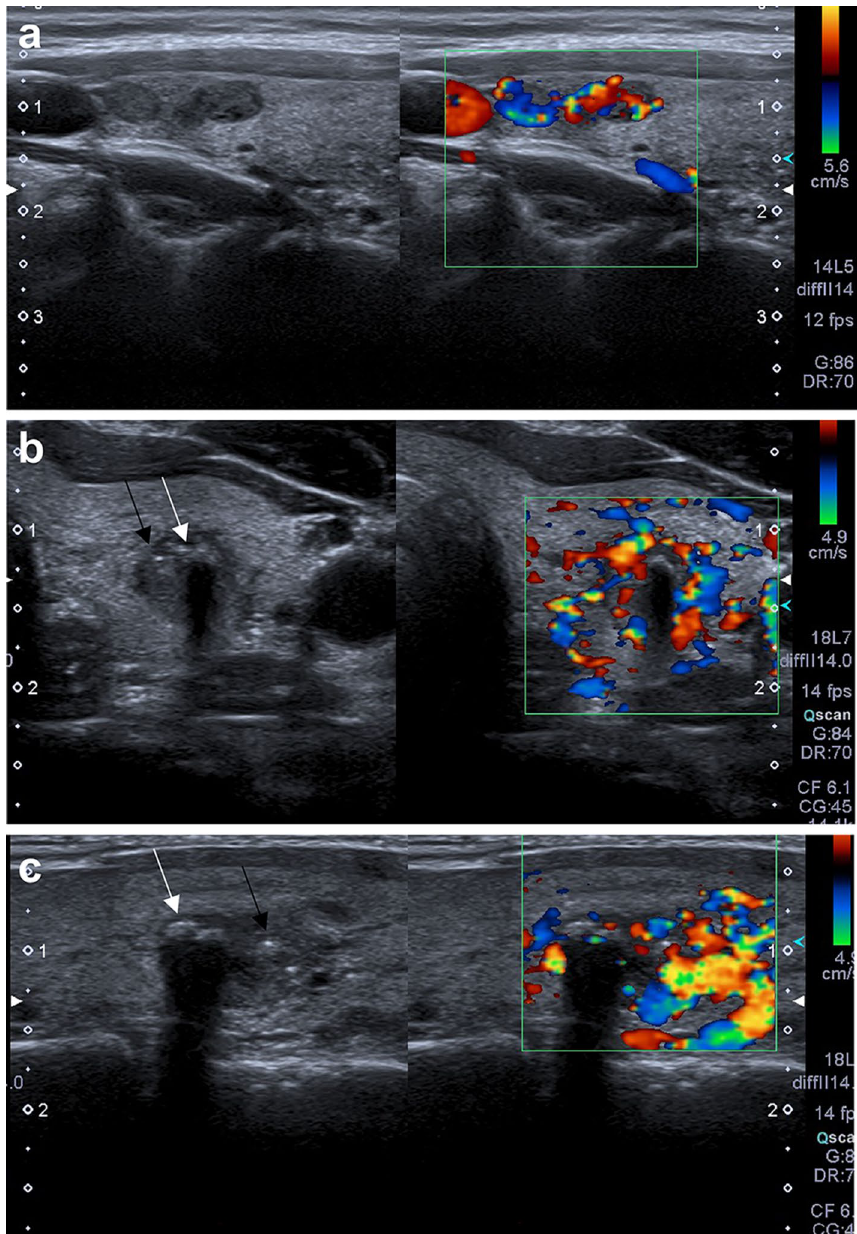
Figure 3. (a–c) Ultrasonographic presentation of familial MNG in DICER1 mut- patients. ( a ) The proband with neuroblastoma and MNG but solid hypoechogenic lesions with increased blood flow on Color Doppler. The histopathological result was hyperplastic nodules/nodular goiter. ( b,c ) The proband’s mother with MNG, cystic and solid lesions with increased blood flow on color Doppler. Both macrocalcifications (white arrows) and microcalcifications (black arrows) were observed. The patient has not yet undergone